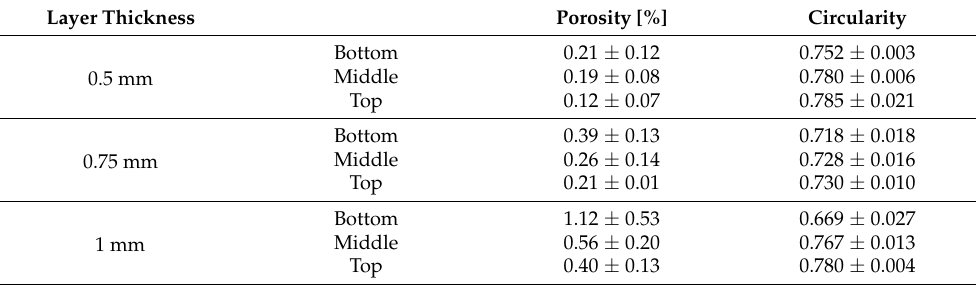
Table 4. Porosity measurement results. Results given with a single standard deviation. Circularity define shape of the pores and is calculated as: circularity = (4· Π ·S)/L 2 , where: S—area of pore, L— length of the perimeter of the pore.